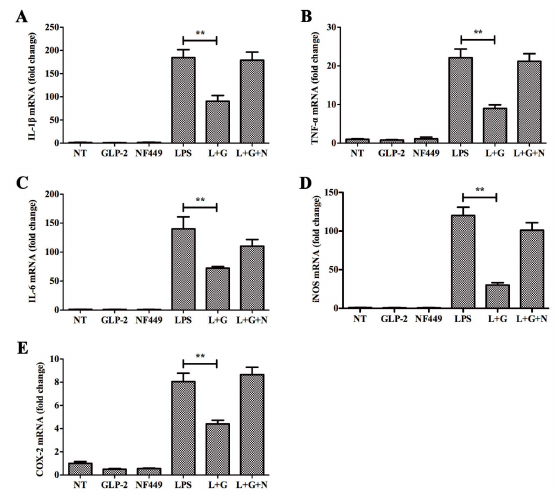
Figure 4. Effects of GLP-2 mediated by G α s signaling pathway. BV-2 cells were pretreated with vehicle or NF449 for 1 h. Medium was removed and replaced with vehicle, GLP-2 (10 ´ 6 M), NF449 (10 µ M), LPS (1 µ g/mL), LPS + GLP-2 (L + G), or LPS + GLP-2 + NF449 (L + G + N). BV-2 cells were sampled at 4 h. The mRNA of pro-inflammatory enzymes and pro-inflammatory cytokines were determined by quantitative real-time PCR. Attenuation by GLP-2 of LPS-induced mRNA of IL-1 β ( A ); TNF- α ( B ); IL-6 ( C ); iNOS ( D ); and COX-2 ( E ) from BV-2 cells; this effect is abolished by pretreatment with NF449, ** p <